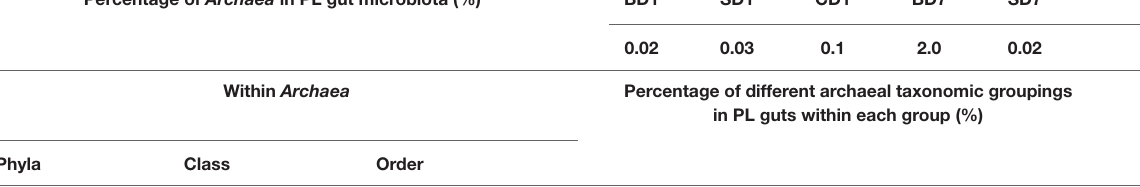
TABLE 9 | Relative abundance of Archaea in PL gut microbiota and their compositions. Percentage of Archaea in PL gut microbiota (%)